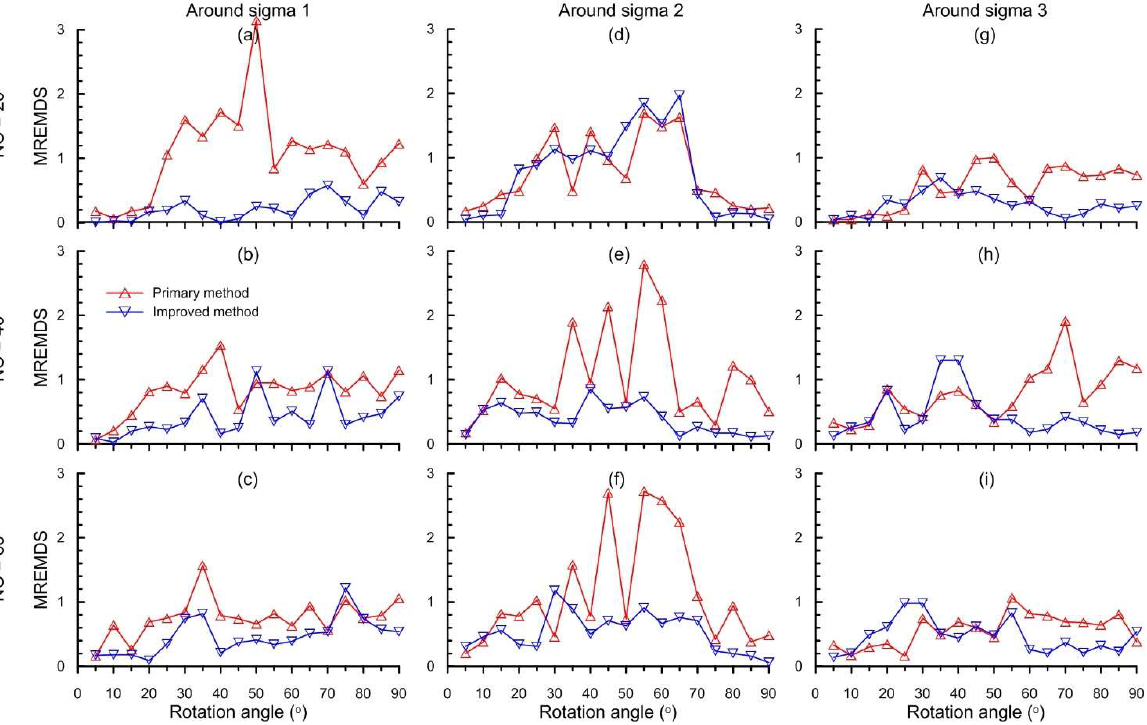
Figure 5. Variation of the maximum relative error of the maximum differential stress (MREMDS) with rotation angle in the case of rotation around ( a – c ) σ 1 , ( d – f ) σ 2 , and ( g – i ) σ 3 ,